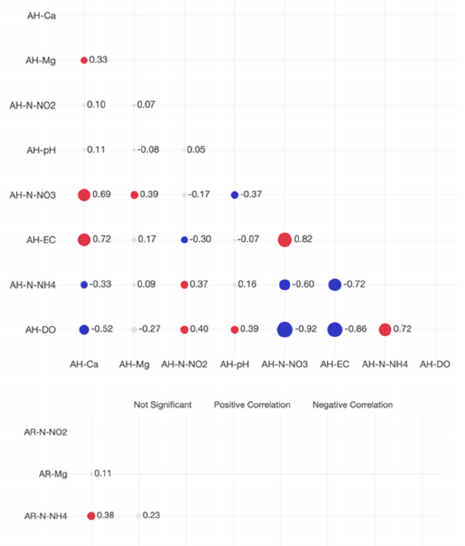
Figure A12. The PAC with transformation in square roots—BR series.